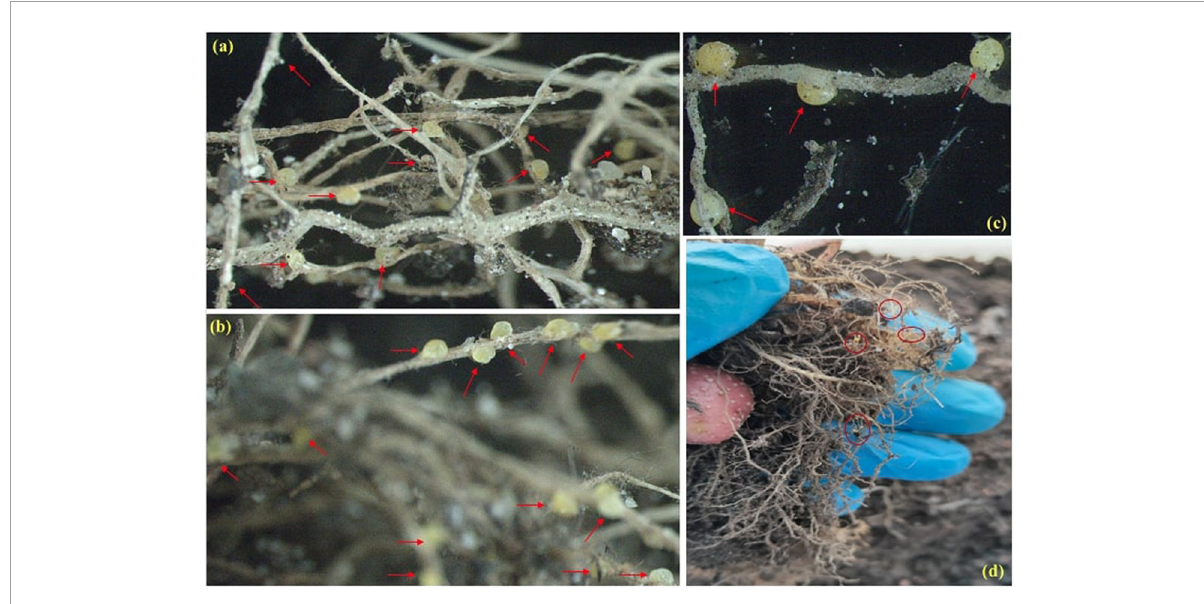
FIGURE6 Images of cysts developed on potato roots (2–10 × magnification) in: (a) Untreated control; (b) Nemguard TM treated; (c) MFP5075 treated; and (d) MFP3048 treated. Red arrows in the pictures indicate the cysts or females developed on each root system.